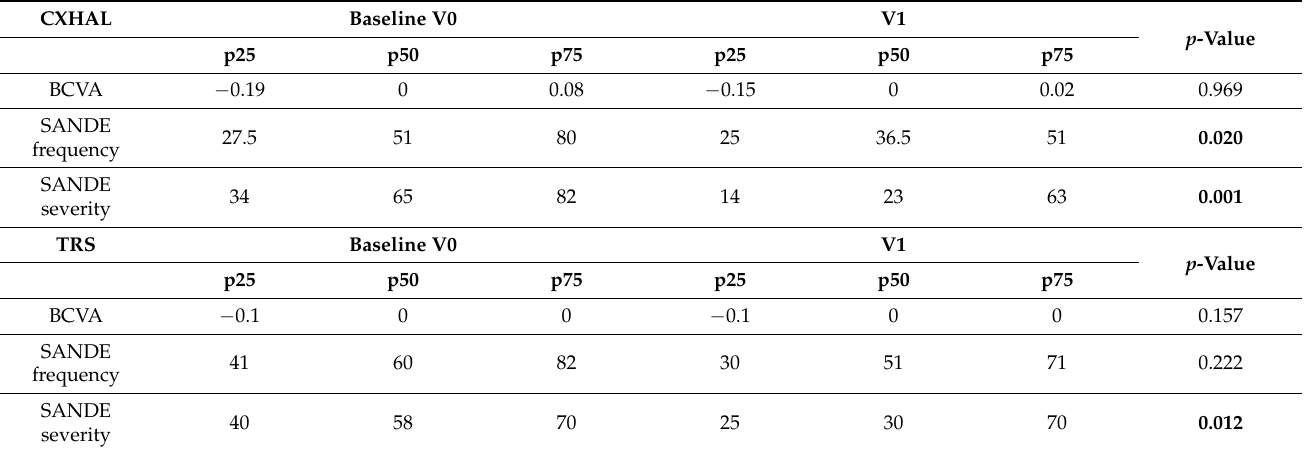
Table 1. The BCVA and SANDE questionnaire results in both groups of treatments. Numerical variables are expressed as the median (p50), 25% (p25) and 75% (p75) percentiles. Statistically significant p values are highlighted in bold.